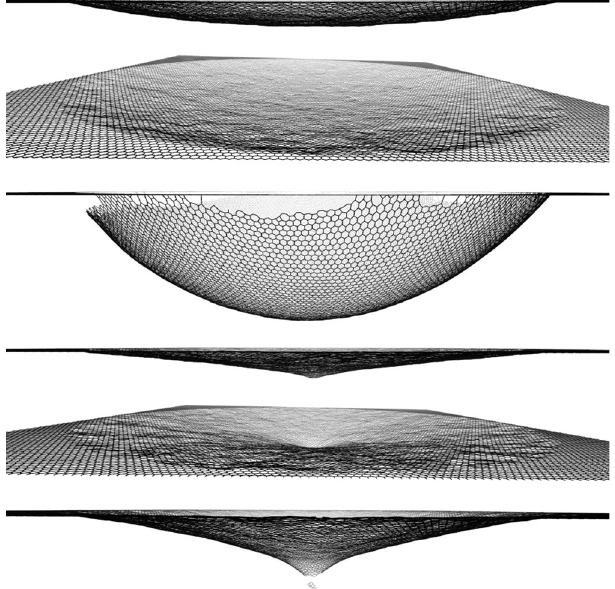
Fig. 2 Snapshots from simulations of the indentation of a graphene drum with diameter L ≃ 315 Å under uniform load ( upper three graphs ) and point load ( lower three graphs ). In the graphs with a view at an angle, one can see the thermal corrugation of the drum, responsible for the anharmonic effects. The bottom graphs show con fi gurations just after breaking. For uniform load breaking occurs at the drum edge at P ’ 60kbar , while for point load it occurs around the tip at F ’ 160nN for the given system